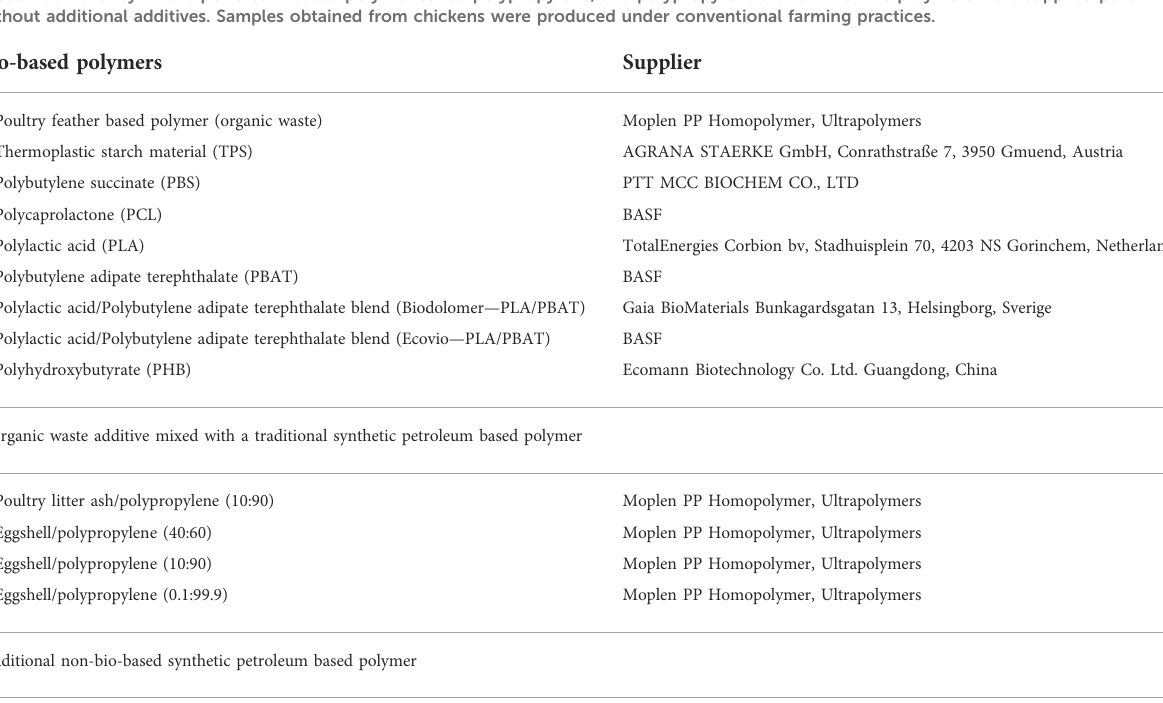
TABLE 3 Nature and supplier details of the polymer samples assessed in this study including; bio-based, inorganic bio-based mixed with a non-bio- based traditional synthetic petroleum based polymer called polypropylene, and polypropylene alone. All of the polymers were supplied pure without additional additives. Samples obtained from chickens were produced under conventional farming